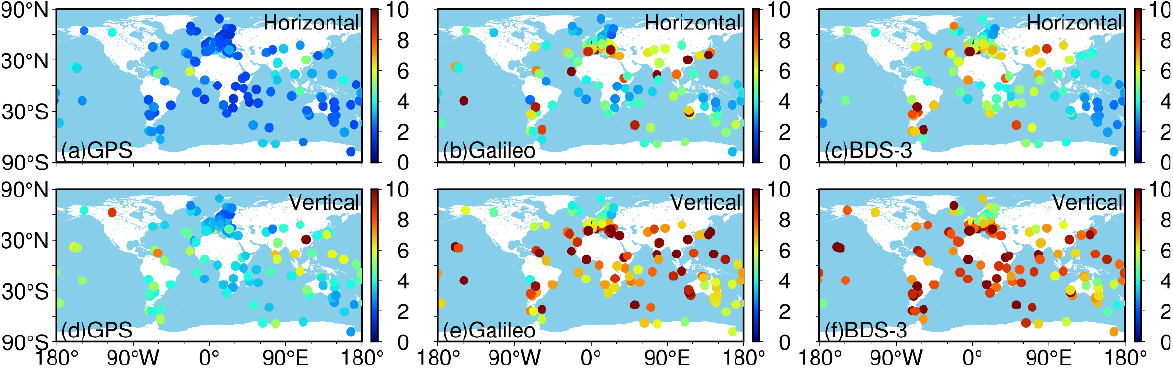
Figure 10. Geographical distribution of the median RMS of kinematic PPP for the selected 143 worldwide MGEX tracking stations over a month period (September 2022) using three single systems. Table 4. The mean RMS (unit: cm) of the different latitudes for static PPP. Table 5. The mean RMS (unit: cm) of the different latitudes for kinematic PPP. Latitude High_N Med_N Low_N Low_S Med_S High_S GPS_H